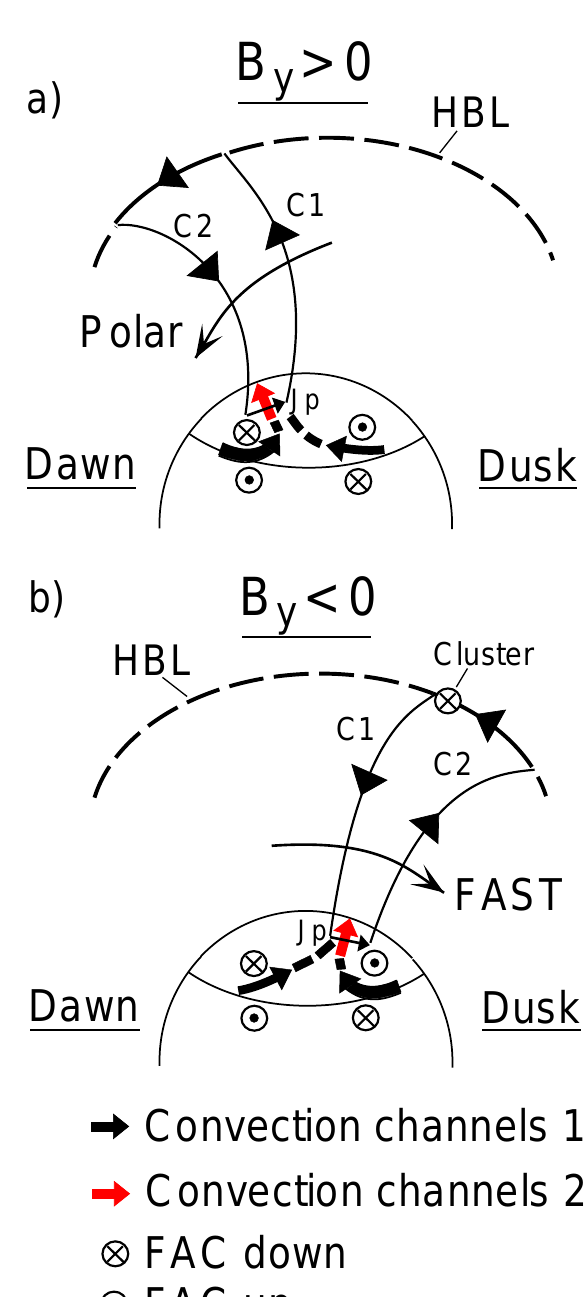
Fig. 26. Schematic illustration of dayside field-aligned current sys- tems and plasma convection corresponding to the auroral morphol- ogy documented in this paper. The IMF B y > 0 case is shown in the upper panel. Dayside R1/R2 currents is associated with type 1 convection channel threaded by newly-open field lines. The C1/C2 FACs are threaded by old open field lines on the downstream side of the cusp. The closure of the latter currents at high and low alti- tudes are indicated. The associated type 2 convection channel in the polar cap is marked red. The IMF B y < 0 case is shown in the lower panel. Trajectories of spacecraft Polar, FAST and Cluster used to document these currents are